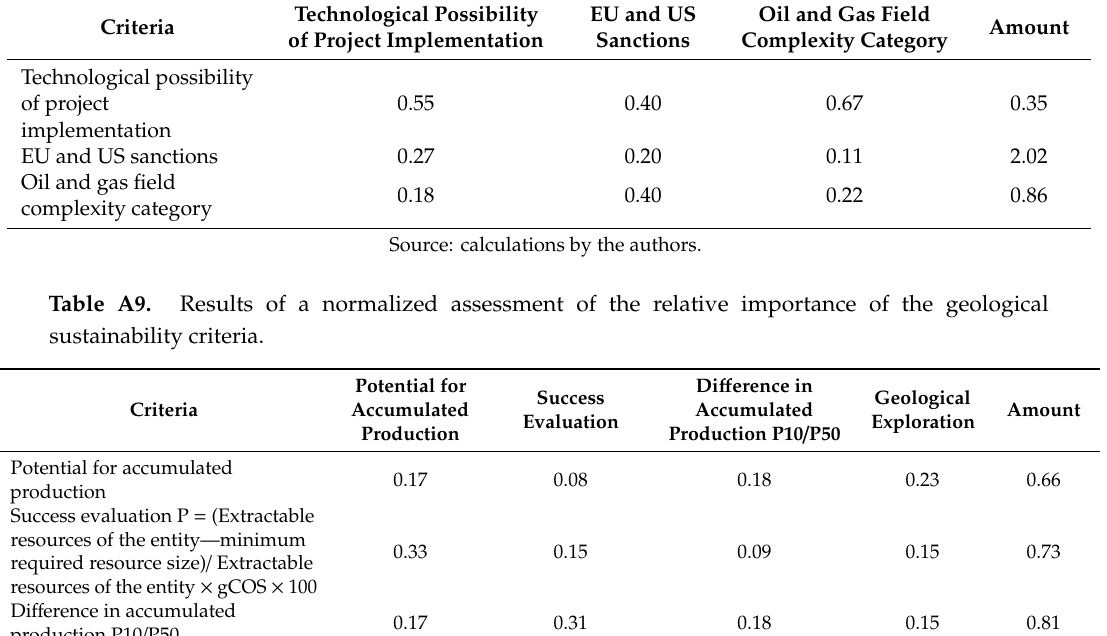
Table A10. Results of a normalized assessment of the relative importance of the social sustainability criteria.